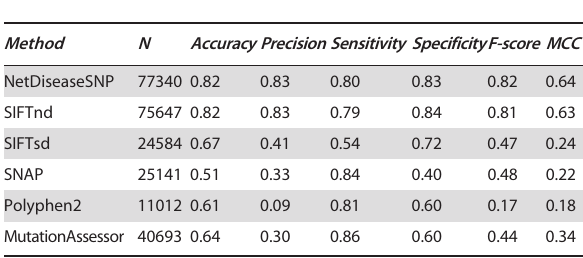
Table 2. Benchmark of